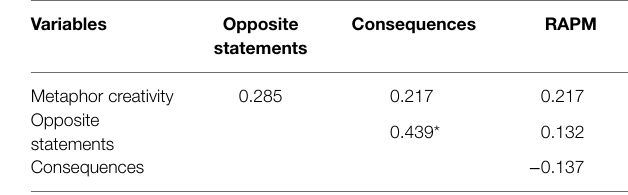
TABLE 4 | Correlations between overall measures for metaphor creativity, cognitive flexibility, and